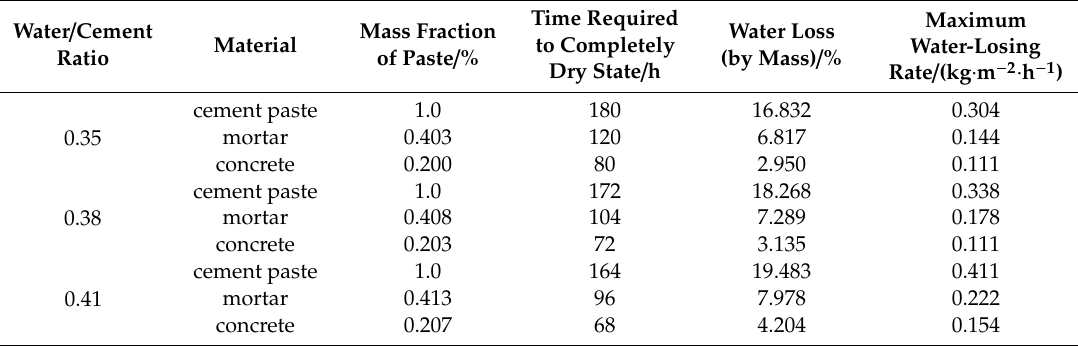
Figure 3. Water-losing rate of cement paste, mortar, and concrete. Table 5. Drying results of cement paste, mortar, and concrete.